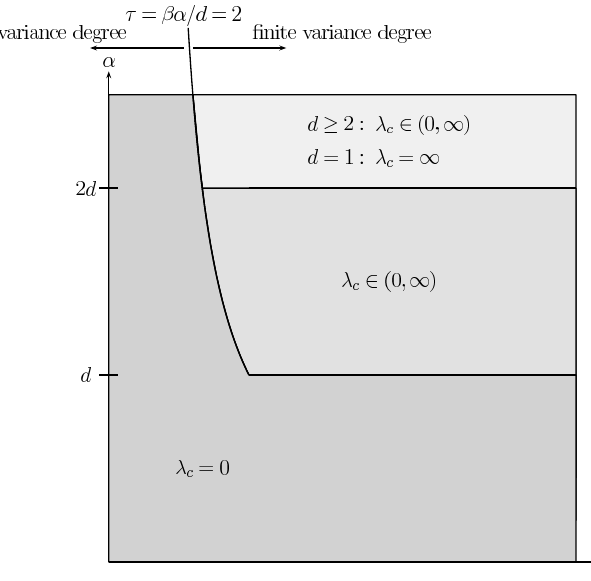
Figure 1. phase transition picture for d ≥ 1